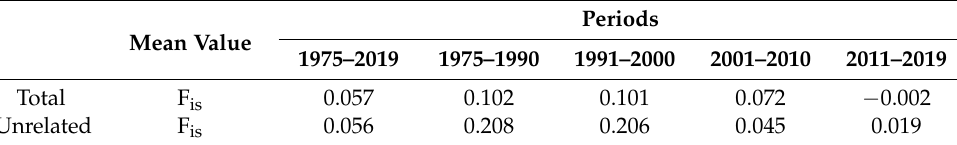
Figure 2. Mean values ( left ) and their plot ( right ) of the observed (Ho) and expected (He) heterozygosity of unrelated horses in different periods. The number of horses and the HWE (P-val) per group are reported on the left.